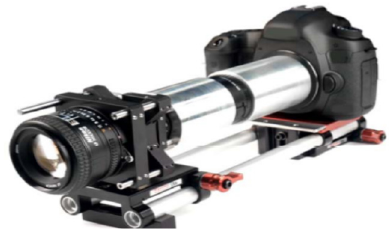
Figure 1. Holoscopic 3D camera prototype by 3DVJVANT project at Brunel University London [20].